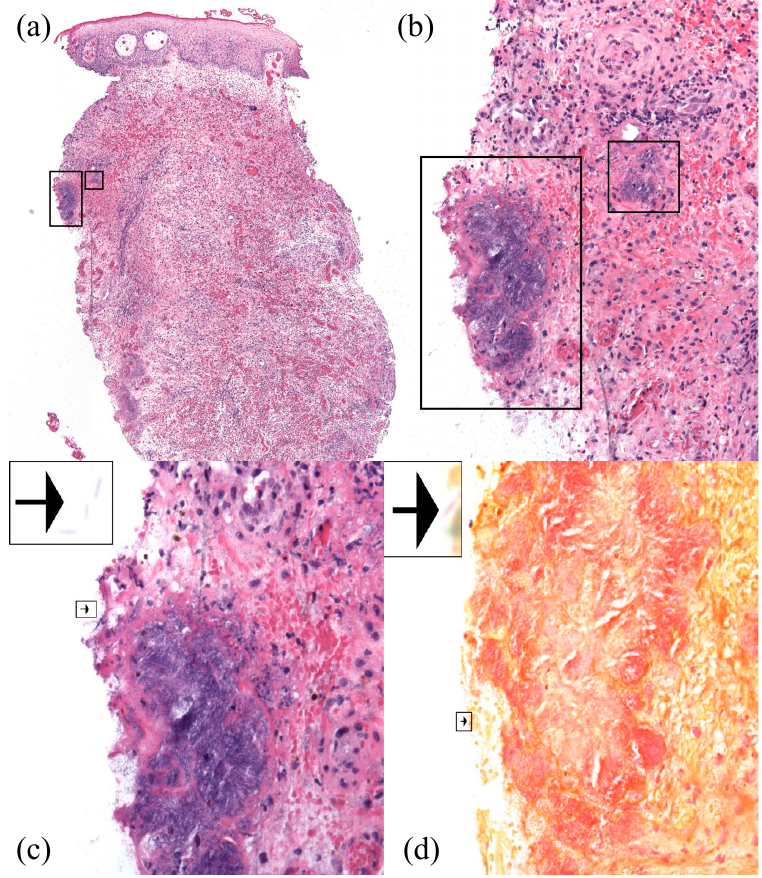
Figure 2. Histopathology (hematoxylin and eosin) demonstrated numerous organisms with a rod to focally filamentous morphology, as well as edema, dilated blood vessels, extravasated erythrocytes, and mixed inflammatory infiltrate at 40× ( a ), 200× ( b ), and 400× ( c ). Gram stain confirmed the presence of Gram-negative organisms, consistent with S. maltophilia ( d , 400×). Individual organisms were visualized at the edge of the tissue specimen (arrows).